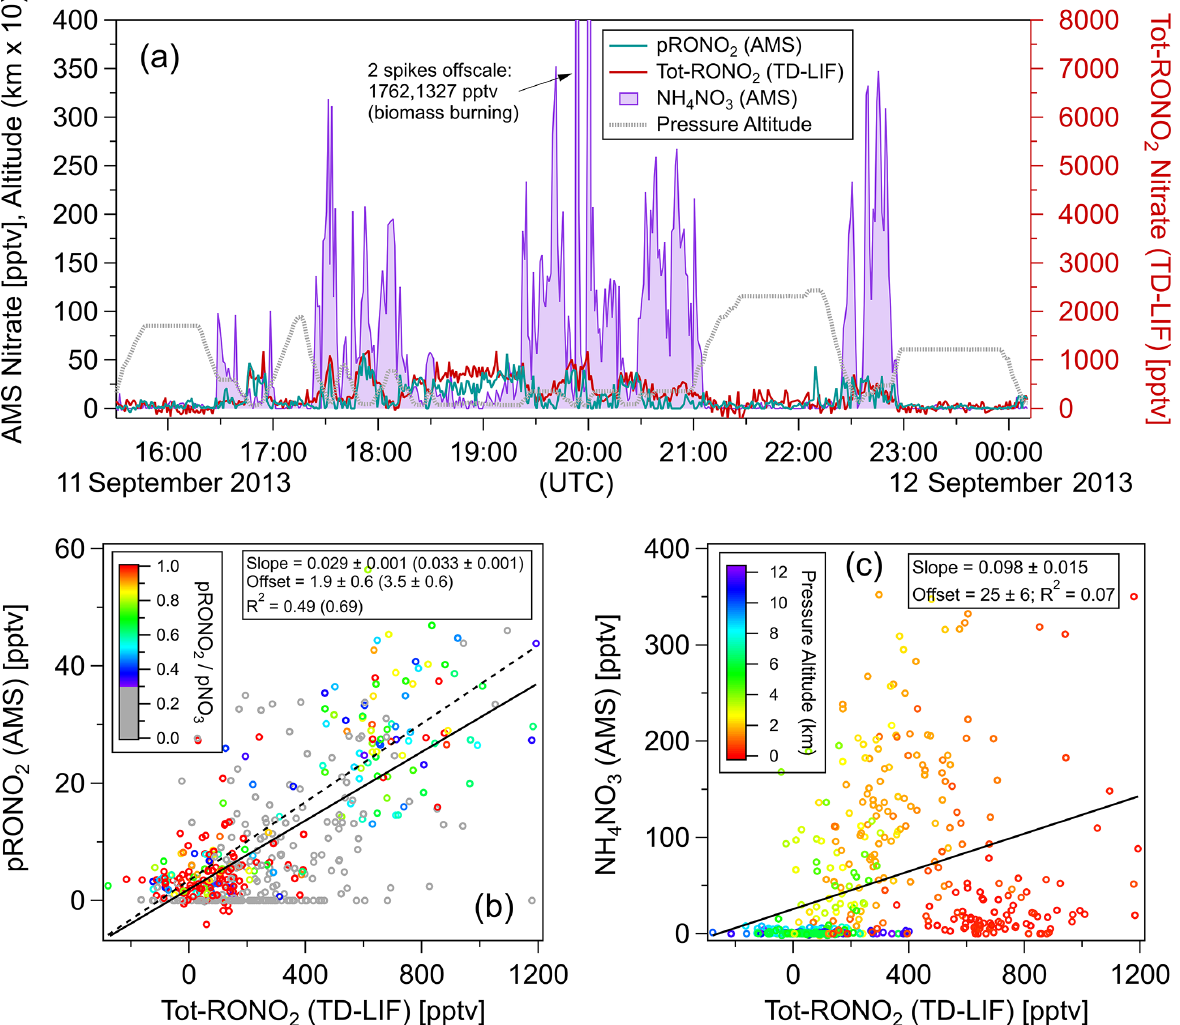
Figure 3. Comparisons of AMS pRONO 2 and NH 4 NO 3 with TD-LIF total (gas + particles) organic nitrate (Tot-RONO 2 ) during a SEAC 4 RS flight (RF16) in the Southeast United States (1min averages). The time series (a) and scatterplots of pRONO 2 (b) or NH 4 NO 3 (c) vs. Tot- RONO 2 are shown. Measured calibration R NH (consistent with PMF results in Sect. 5.2.2), a RoR of 2.75, and Eq. (1) were used to 4 NO 3 apportion the AMS nitrate. Linear least-squares lines are orthogonal distance regression (ODR). For the pRONO 2 vs. Tot-RONO 2 plot (b) , an additional line (dotted) and fits (parentheses) are shown for data including only when f pRONO (pRONO 2 / pNO 3 ) is greater than 0.3 (and 2 < 0.3 are greyed). Figure S10 shows the flight track and timing of different source types data points with f pRONO 2